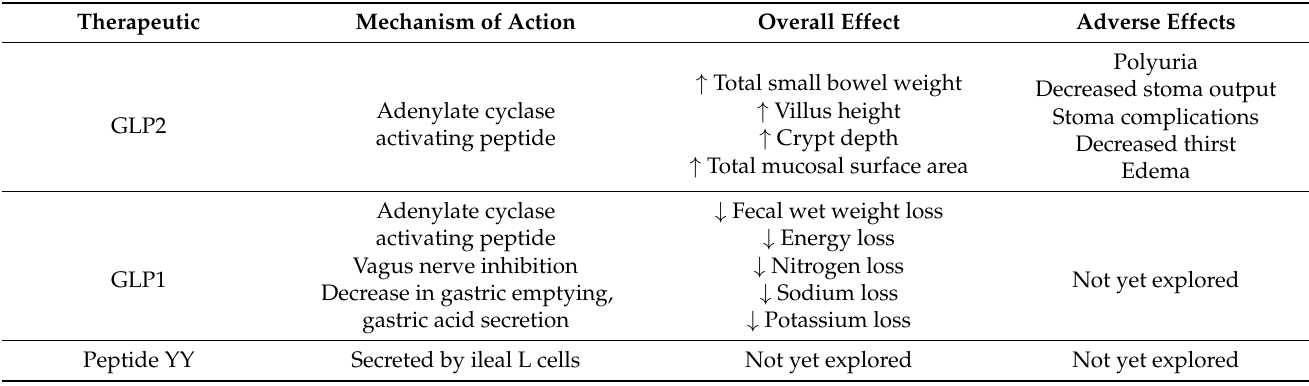
Table 1. Therapeutics for SBS 1